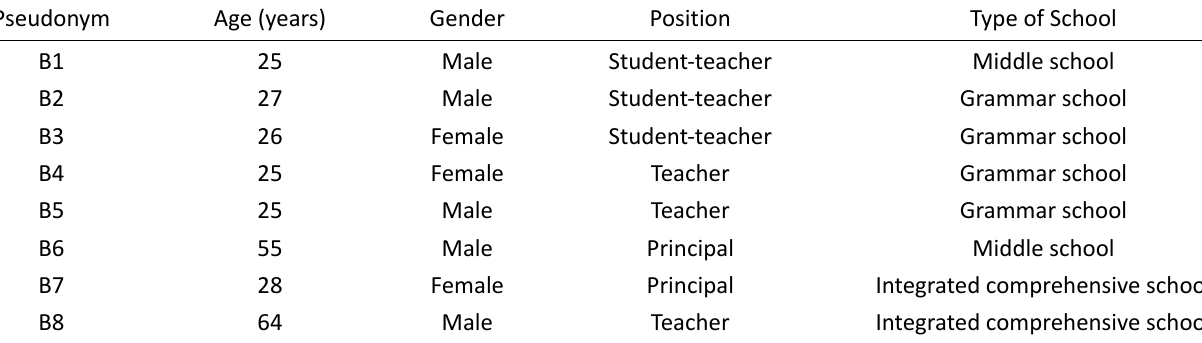
Table 1. An overview of the interview